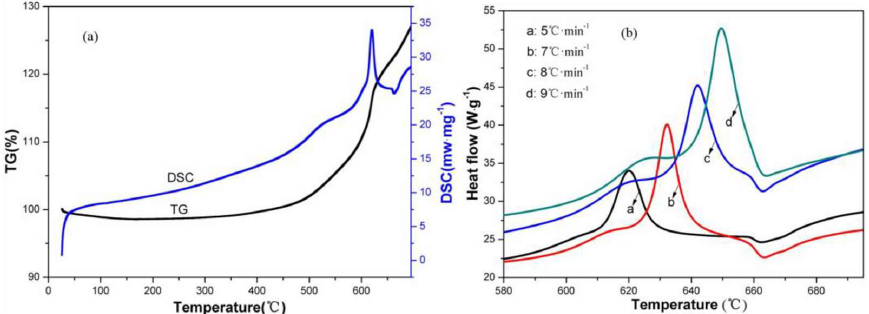
Figure 5. ( a ) DSC-TG curves with a heating rate at 5 ° C min −1 ; ( b ) DSC curves at different heating rates (5, 7, 8, 9 ° C ·min −1 ).